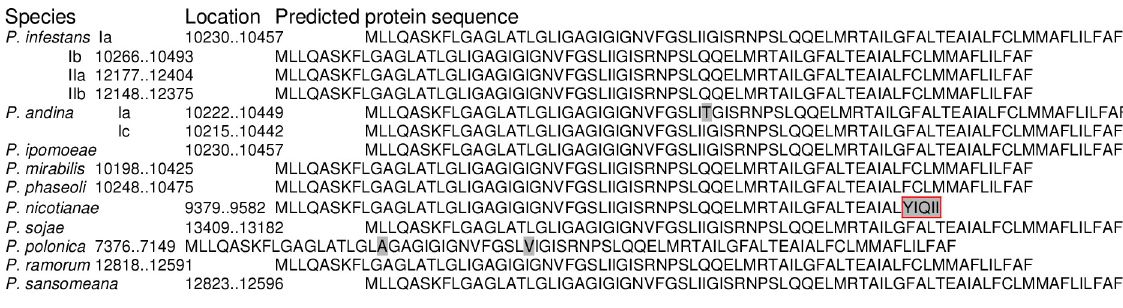
Fig 3. Deduced protein sequences of atp9 gene in the mitochondrial genomes of 10 Phytophthora species. Amino acids differ from the consensus are shaded in grey. A deletion at the 3’ end of this gene in P . nicotianae results in the replacement of the last 13 amino acids with five non-homologous ones (boxed in